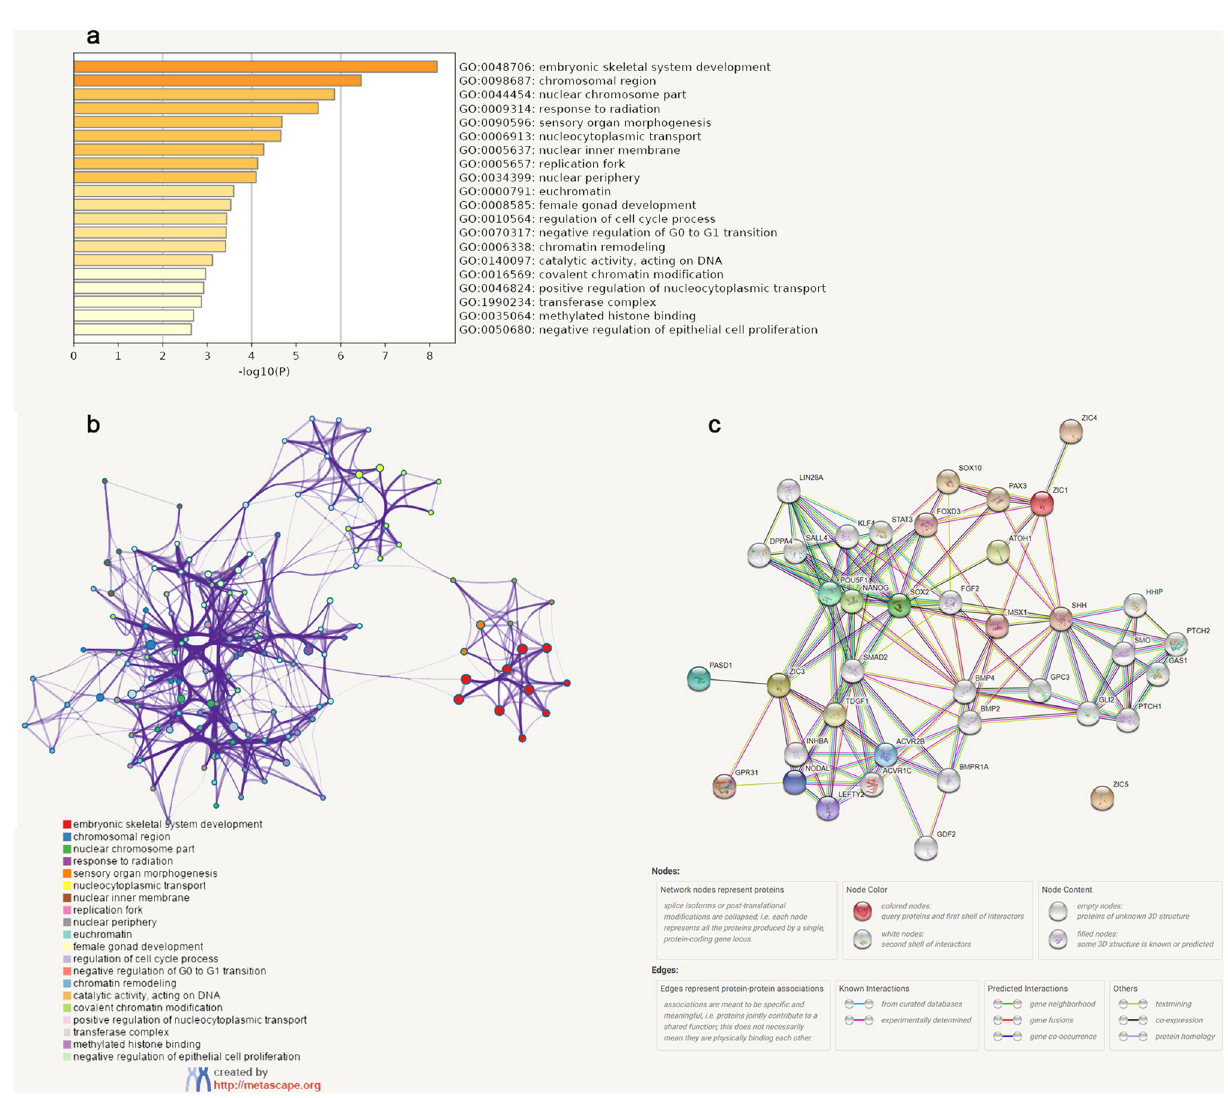
Figure 6. Enrichment analysis of ZIC1 and similar genes in glioma via Metascape. Heatmap of enriched terms across ZIC1, coloured by p-values ( a ). Interactive networks of enriched terms ( b ). B Distinct colours represent different pathway enriched by ZIC-correlated genes. The PPI networks of ZIC1 and ZIC3 ( c